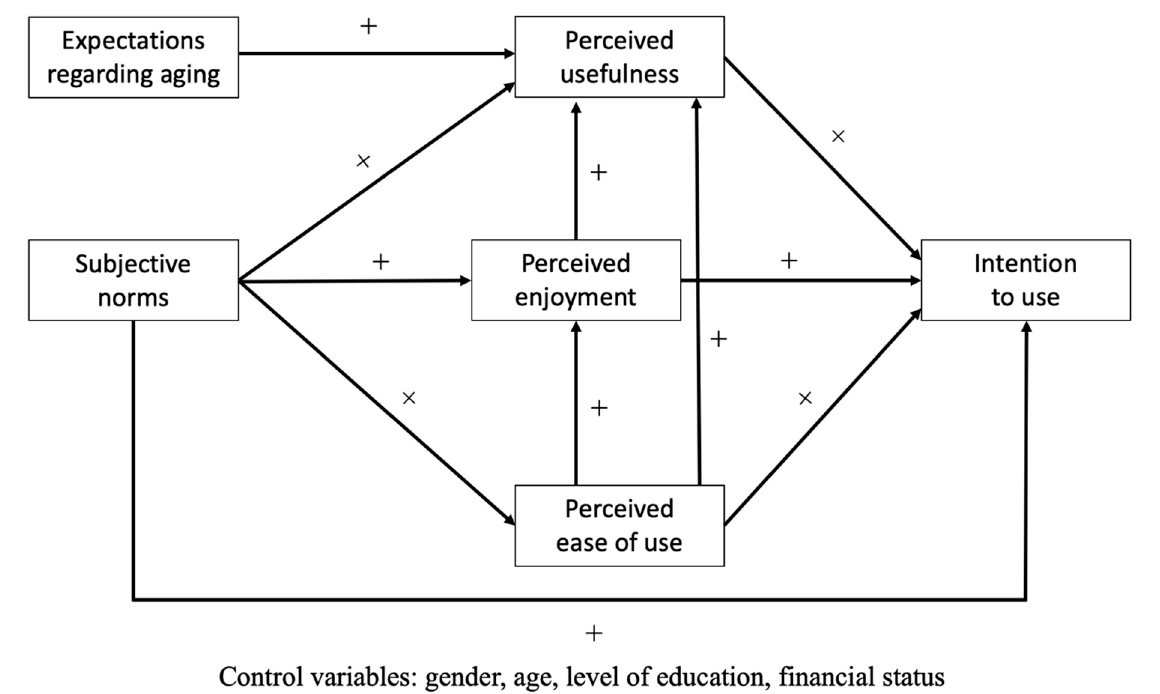
Figure 1. The hypothesized model. Note: + indicates a positive prediction.